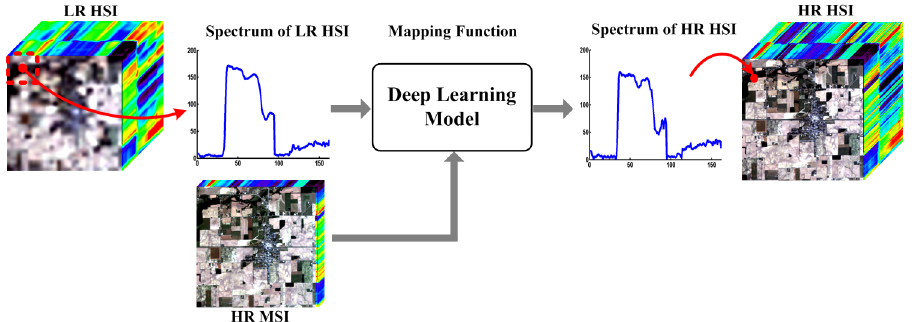
Figure 2. ( a ) Color composite (bands 29, 16, 8) of HR HSI (left) and LR HSI (right), the image is cropped from AVIRIS Indian pines data; ( b ) Spectra of two different land-covers in HR HSI and LR HSI, the two land-covers are marked in ( a ).